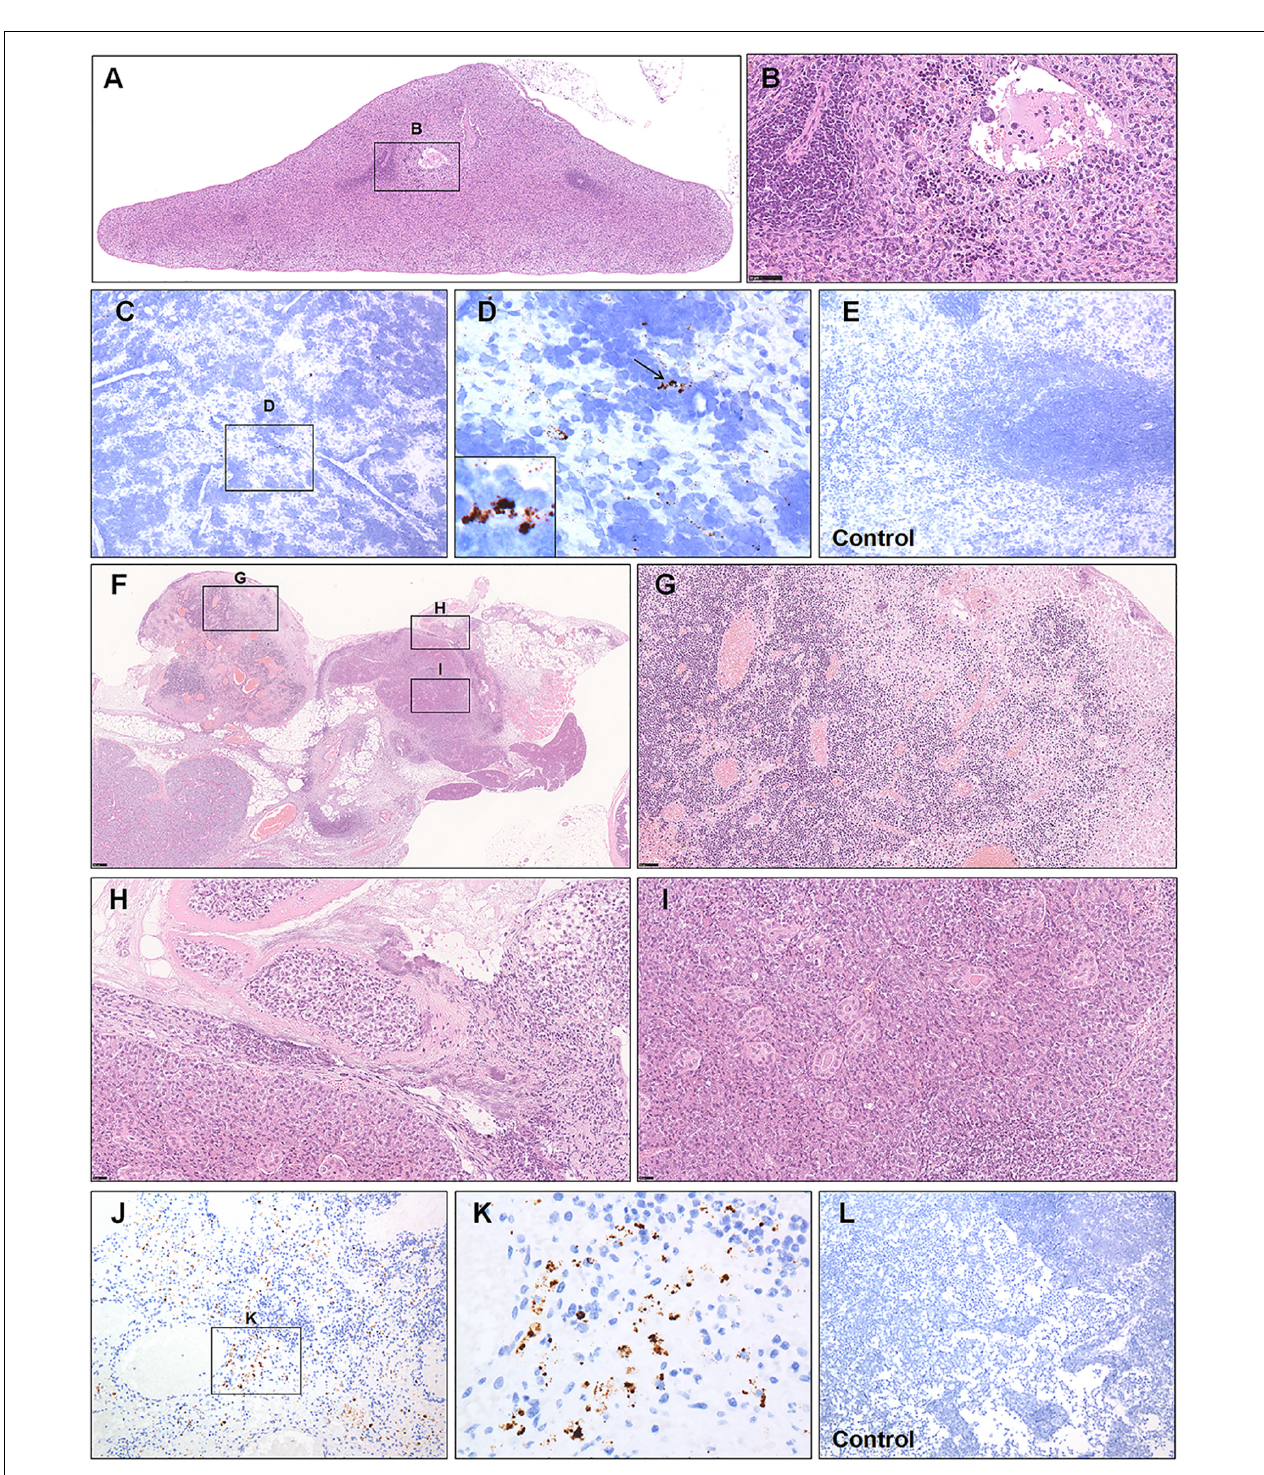
FIGURE 3 | Observation and examination of the spleen and lymph nodes. (A,B) White and red pulp depletion with a reduction in the follicle number and size in infected hamsters at 7 dpi. (C–E) Low viral RNA expression was detected by ISH in the splenic marginal zone and red pulp compared with the control group at 7 dpi. The black frames in the corner of (D) is the magnification of the arrowed region. (F–I) The germinal center of the affected mandibular lymph node had disappeared and been displaced by massive necrotic areas at 5 dpi. (J–L) Some viral RNA expression was detected by ISH in the parenchyma of the medulla compared with the mock control group at 5 dpi. Sequential sections were stained by H&E and subjected to ISH. Data are representative of three independent experiments.